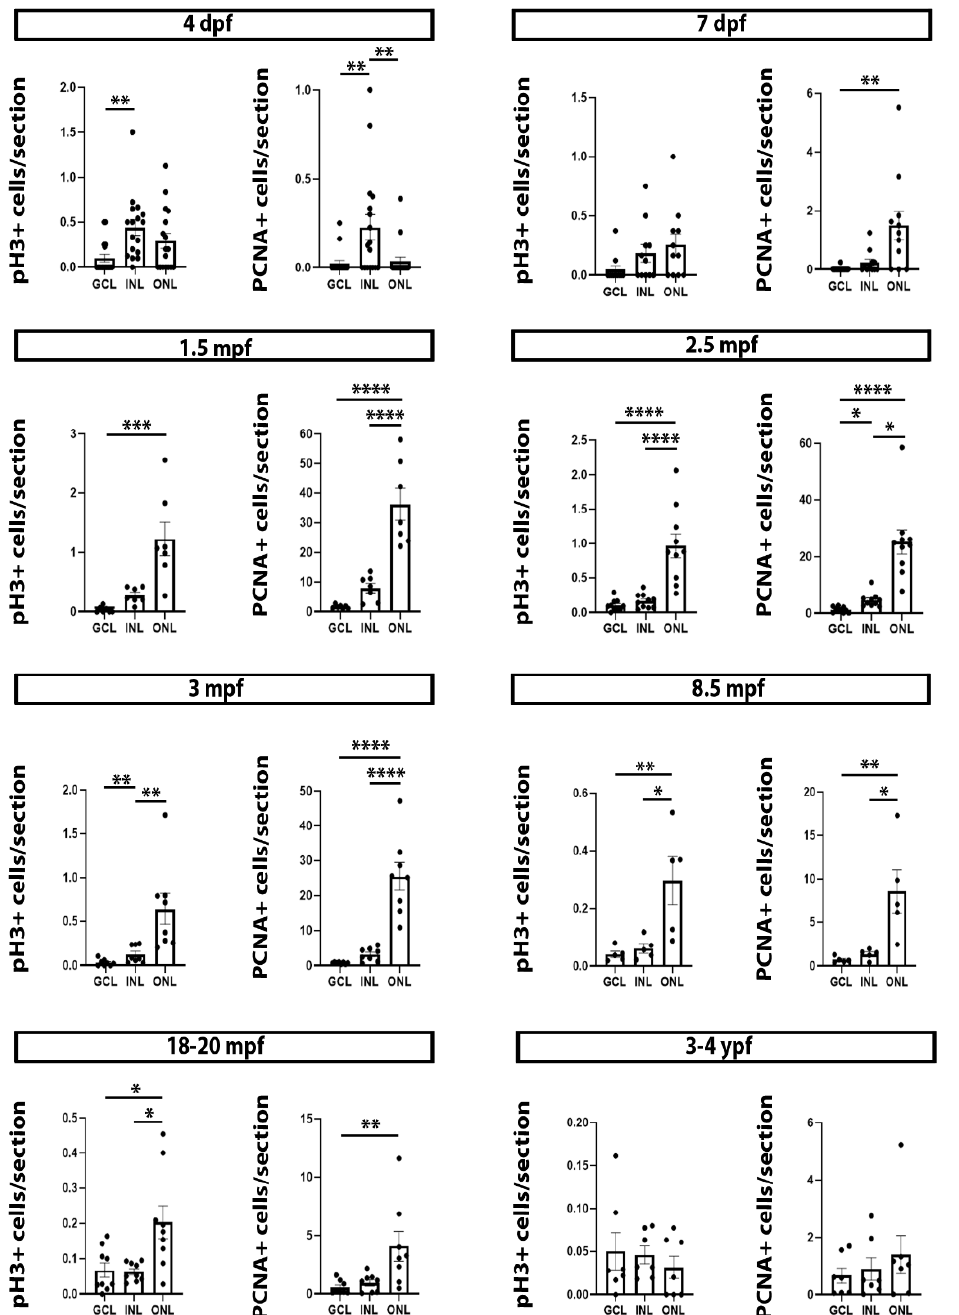
Figure 3. Graphs showing the differential distribution of pH3+ and PCNA+ cells in cell layers of the central retina at different developmental and life stages. 4 dpf specimens: pH3 (Kruskal-Wallis test, p = 0.0022), PCNA (Kruskal-Wallis test, p = 0.0018). 7 dpf specimens: pH3 (Kruskal-Wallis test, p = 0.0655), PCNA (Kruskal-Wallis test, p = 0.0024). 1.5 mpf specimens: pH3 (Kruskal-Wallis test, p < 0.0001), PCNA (one-way ANOVA, p < 0.0001). 2.5 mpf specimens: pH3 (one-way ANOVA, p < 0.0001), PCNA (Kruskal-Wallis test, p < 0.0001). 3 mpf specimens: pH3 (one-way ANOVA, p = 0.0009), PCNA (one-way ANOVA, p < 0.0001). 8.5 mpf specimens: pH3 (one-way ANOVA, p = 0.0055), PCNA (one-way ANOVA, p = 0.0038). 18–20 mpf specimens: pH3 (Kruskal-Wallis test, p = 0.0121), PCNA (Kruskal-Wallis test, p = 0.0084). 3–4 ypf specimens: pH3 (Kruskal-Wallis test, p = 0.4814), PCNA (Kruskal-Wallis test, p = 0.8584). Mean ± S.E.M. data and data on statistical multiple comparisons related to these graphs can be found on File S2. Asterisks indicate different levels of statistical significance: *, p < 0.05; **, p < 0.01; ***, p < 0.001; ****, p < 0.0001.